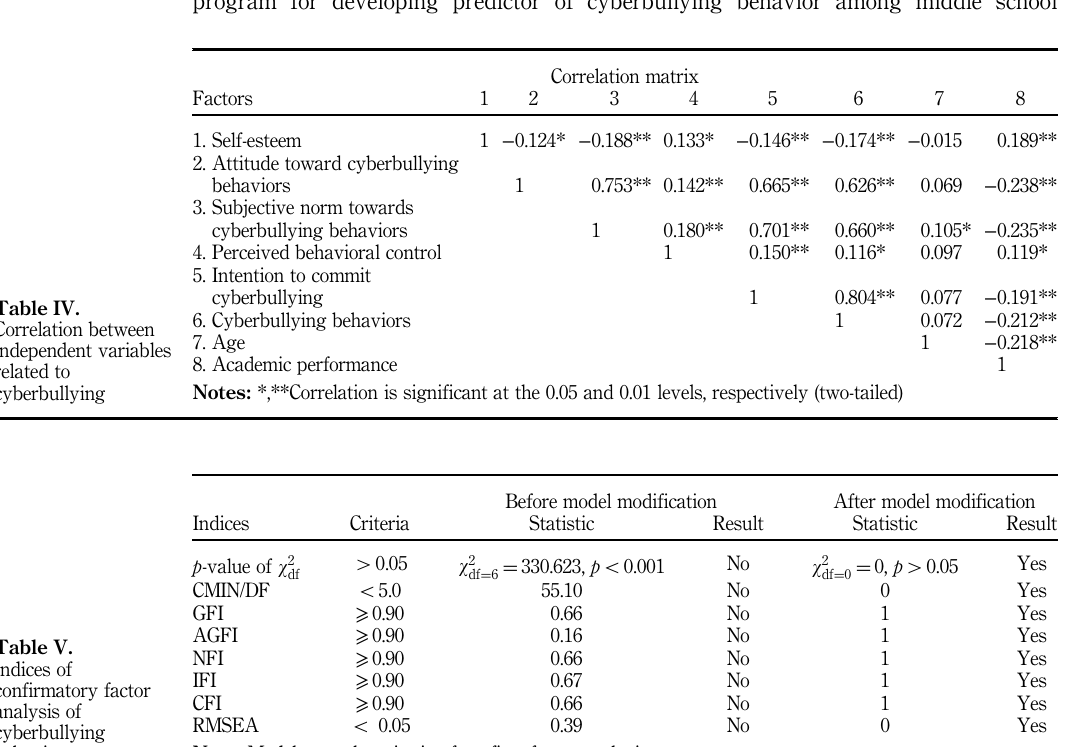
confirmatory factor analysis of cyberbullying